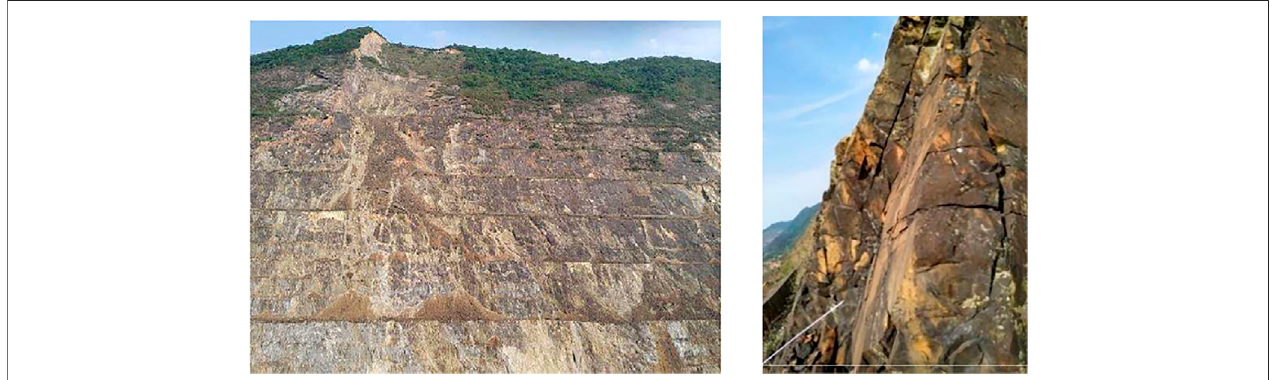
FIGURE 1 | Open-pit slope of Xinqiao Mining Corporation.